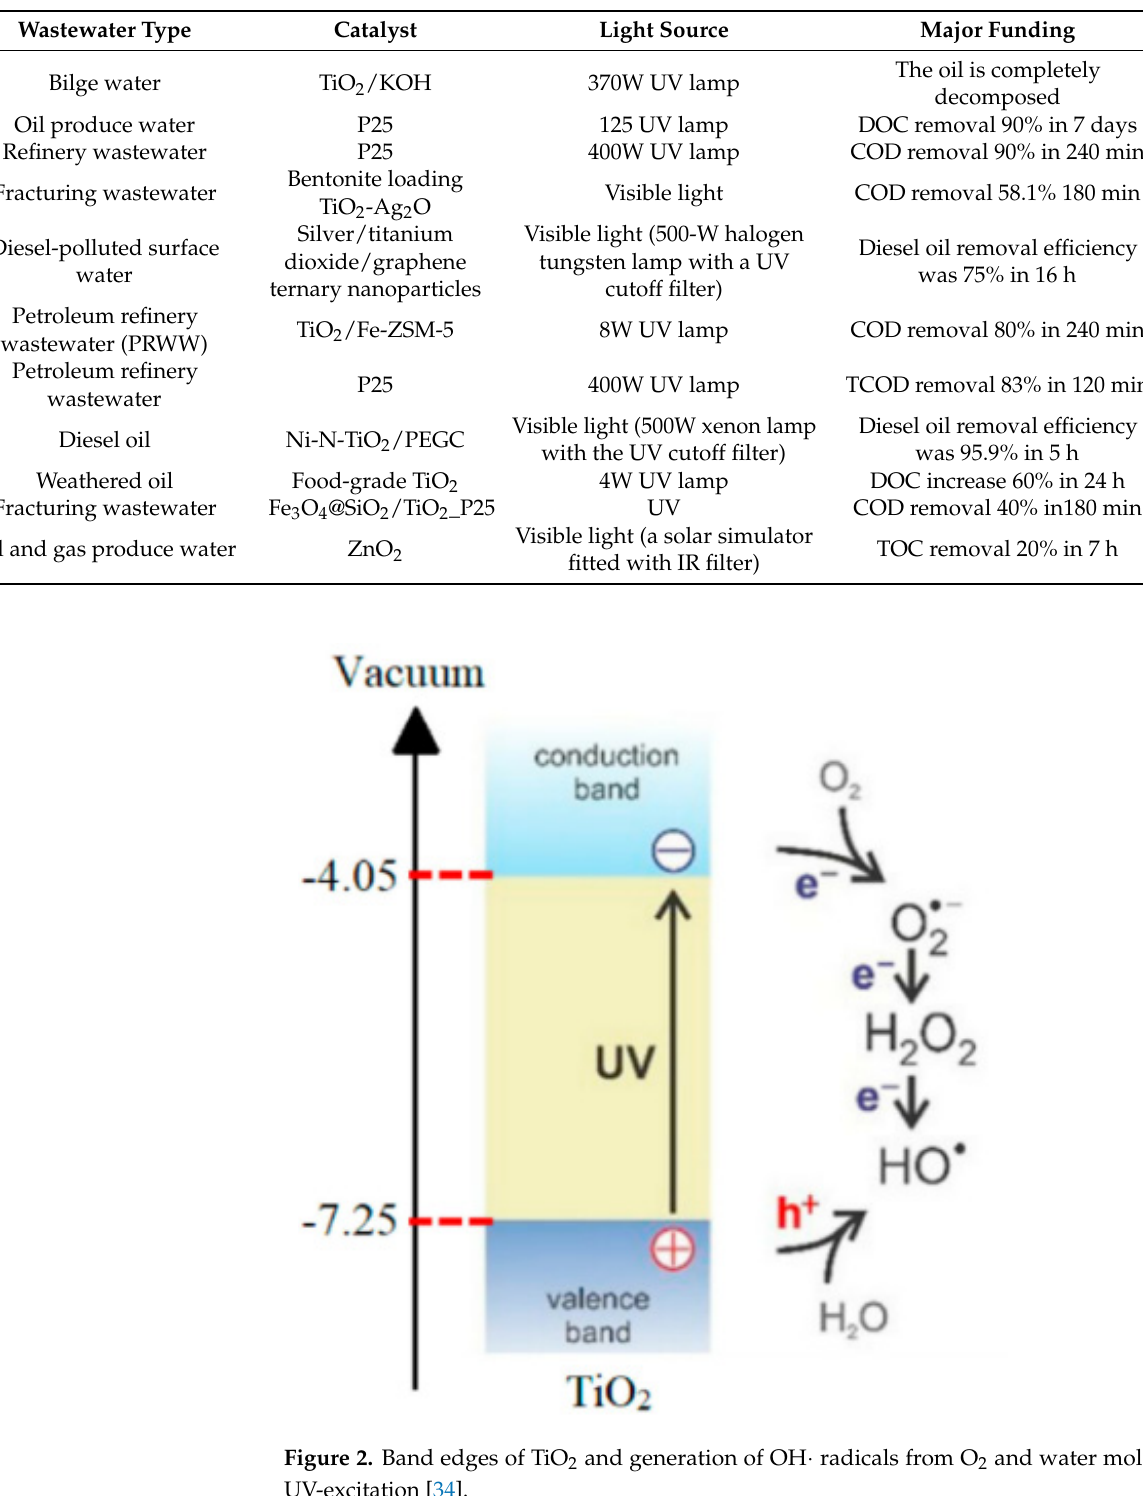
Table 3. A summary of photocatalysis for different types of oil and gas wastewater.